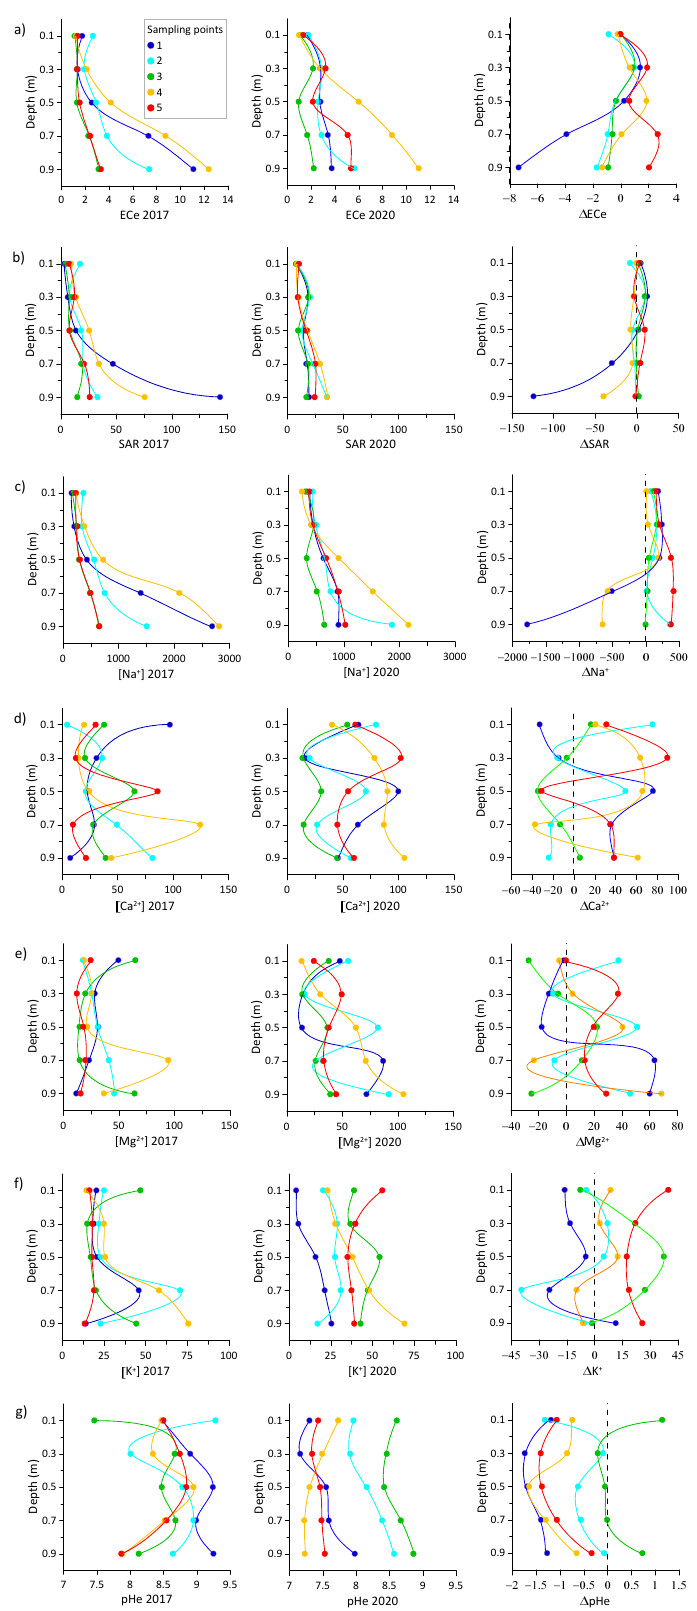
Figure 3. Distributions of ( a ) ECe; ( b ) SAR; ( c ) [Na + ]; ( d ) [Ca 2+ ]; ( e ) [Mg 2+ ]; ( f ) [K + ]; and ( g ) pHe and increments ( ∆ ) between 2017 and 2020, across the soil profile at the five sampling points. ECe is in dS m − 1 ; concentration of cations in mmol c L − 1